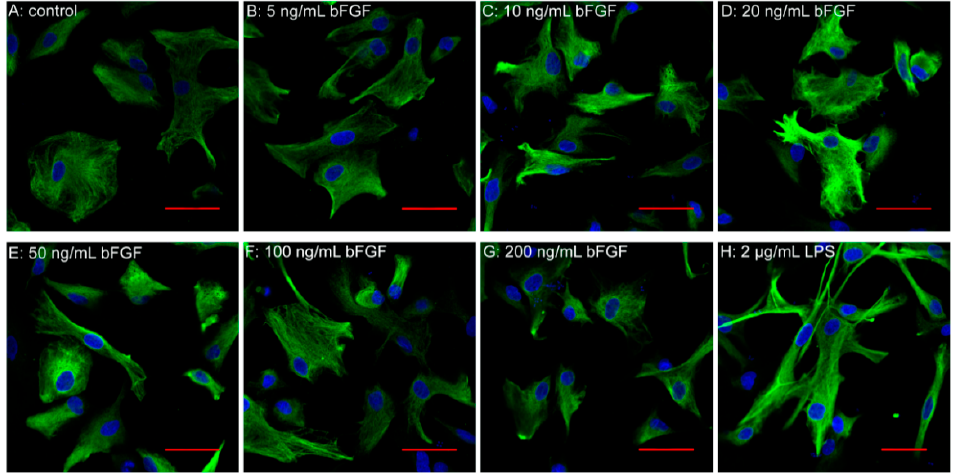
Figure 2. Effect of bFGF on astrocyte activation. Immunofluorescence of GFAP (green) at different concentrations of bFGF and LPS (2 µg/mL). ( A ) Control; ( B ) 5 ng/mL; ( C ) 10 ng/mL; ( D ) 20 ng/mL; ( E ) 50 ng/mL; ( F ) 100 ng/mL; ( G ) 200 ng/mL; ( H ) LPS 2 µg/mL; Scale bar is 50 µm.